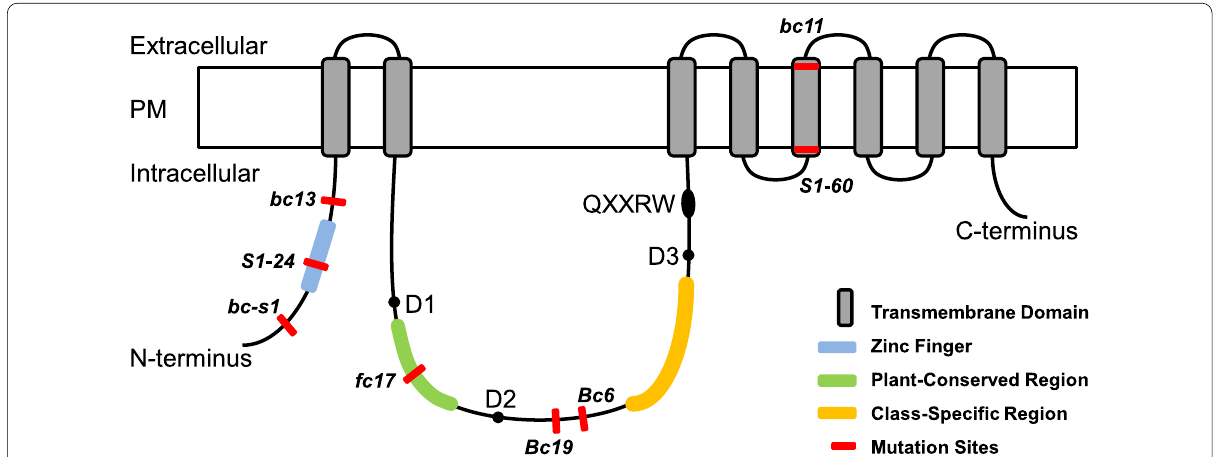
Fig. 7 The predicted structure of a CESA protein showing the relative locations of reported point mutations of CESAs in rice. The basic domain structure of CESA was adapted from a review on cellulose synthesis in Arabidopsis (Li et al. 2014b). The open box stands for the plasma membrane (PM). A Zinc-finger domain (a blue bar) exists towards the N-terminus in the first cytoplasmic domain, followed by two transmembrane domains (TMDs; gray bars), the second cytoplasmic domain between the second and the third TMDs, and the other six TMDs. The Plant-conserved Region (P-CR, a green bar), the conserved D,D,D,QXXRW residues (black spots), and the Class-specific region (C-SR, a yellow bar) are all located in the second cytoplasmic domain. Red bars indicate point missense mutations as follows: bc - s1 (OsCESA9, G10R, Jin et al. 2016), S1 - 24 (OsCESA7, C40Y, Wang et al. 2016a), bc13 (OsCESA9, G101K, Song et al. 2013), fc17 (OsCESA4, F426S, Li et al. 2018), Bc19 (OsCESA4, P507S) in this study, Bc6 (OsCESA9, R588G, Kotake et al. 2011), S1-60 (OsCESA9, G905D, Wang et al. 2012), and bc11 (OsCESA4, G858R, Zhang et al.